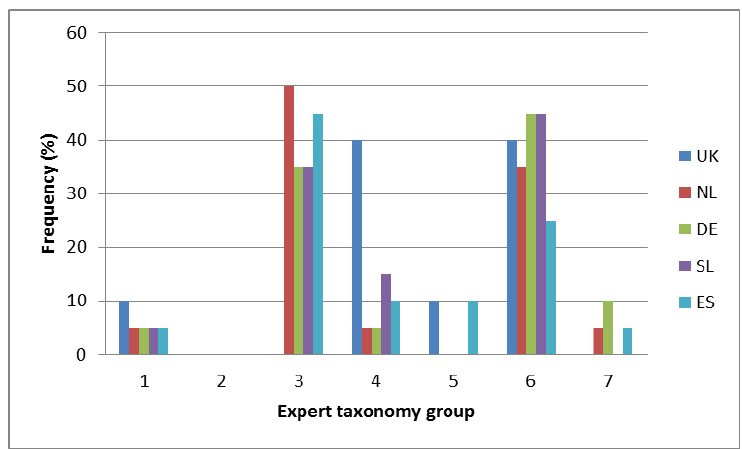
Figure A2. Frequency of structured sort placement of nutrition claims per country—‘Naturally low in sodium’ (Card 20). Nutrients 2018 , 10 , x FOR PEER REVIEW